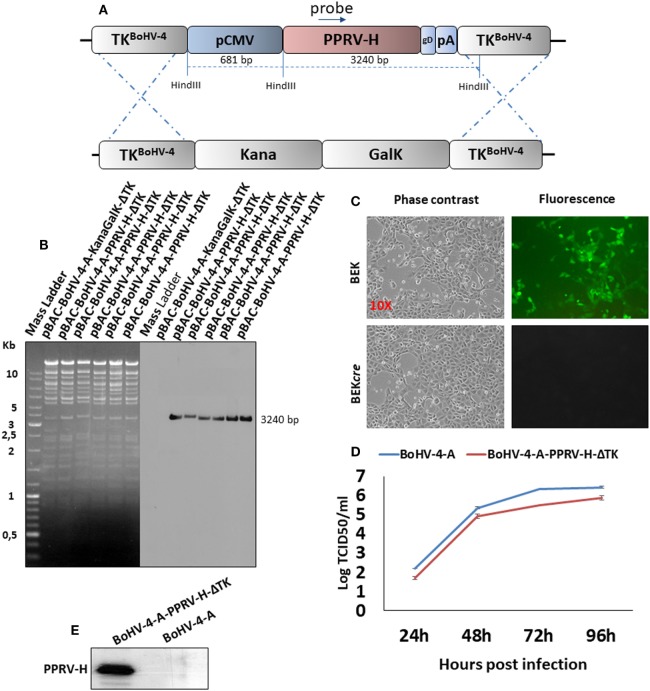
Diagram (not to scale); (A) summarizing the heat-inducible homologous recombination in SW102 containing pBAC-BoHV-4-A-TK-KanaGalK-TK, where the Kana/GalK cassette was replaced with the CMV-PPRV-HgD106 expression cassette flanked by bovine herpesvirus 4 (BoHV-4) TK sequences, located in pINT2 shuttle plasmid vector. (B) Representative 2-deoxy-galactose resistant colonies tested by HindIII restriction enzyme analysis, agar gel electrophoresis, and Southern blotting performed with specific probes for the peste des petits ruminants virus hemagglutinin (PPRV-H) ORF ORFs. The 2,650 bp band, corresponding to the un-retargeted pBAC-BoHV-4-A-TK-KanaGalK-TK control, has been replaced by a 3240 bp band in pBAC-BoHV-4-A-CMV-PPRV-H-ΔTK. (C) Representative phase contrast microscopic images of plaque formed by viable reconstituted recombinant BoHV-4-A-PPRV-H-ΔTK after the corresponding bacterial artificial chromosome (BAC) DNA electroporation into bovine embryo kidney (BEK) cells expressing cre recombinase (Magnification, ×10). (D) Replication kinetics of BoHV-4-A-PPRV-H-ΔTK growth on BEK cells and compared with the parental BoHV-4-A isolate. The data presented are the mean ± standard errors of triplicate measurements (P > 0.05 for all time points as measured by Student’s t-test). (E) Western immunoblotting of cells, infected with BoHV-4-A-PPRV-H-ΔTK or the parental BoHV-4-A used as a negative control. The lanes were loaded with different amounts of total protein cell extract (5, 10, and 20 µg).